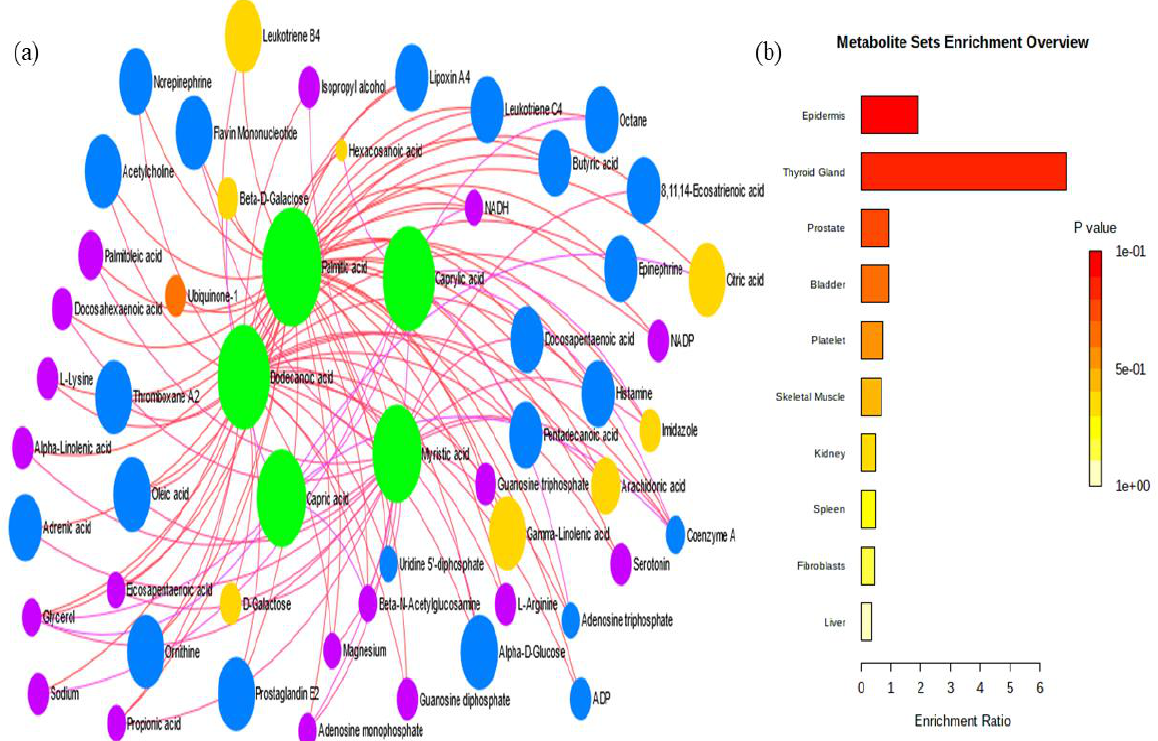
Figure 2. ( a ) Metabolite – metabolite interaction network. The colored circles depict the relationship of metabolites with other metabolite sets. ( b ) Metabolite set enrichment analysis (MSEA) for identified metabolites. Table 4. Over-representation analysis of compounds in different